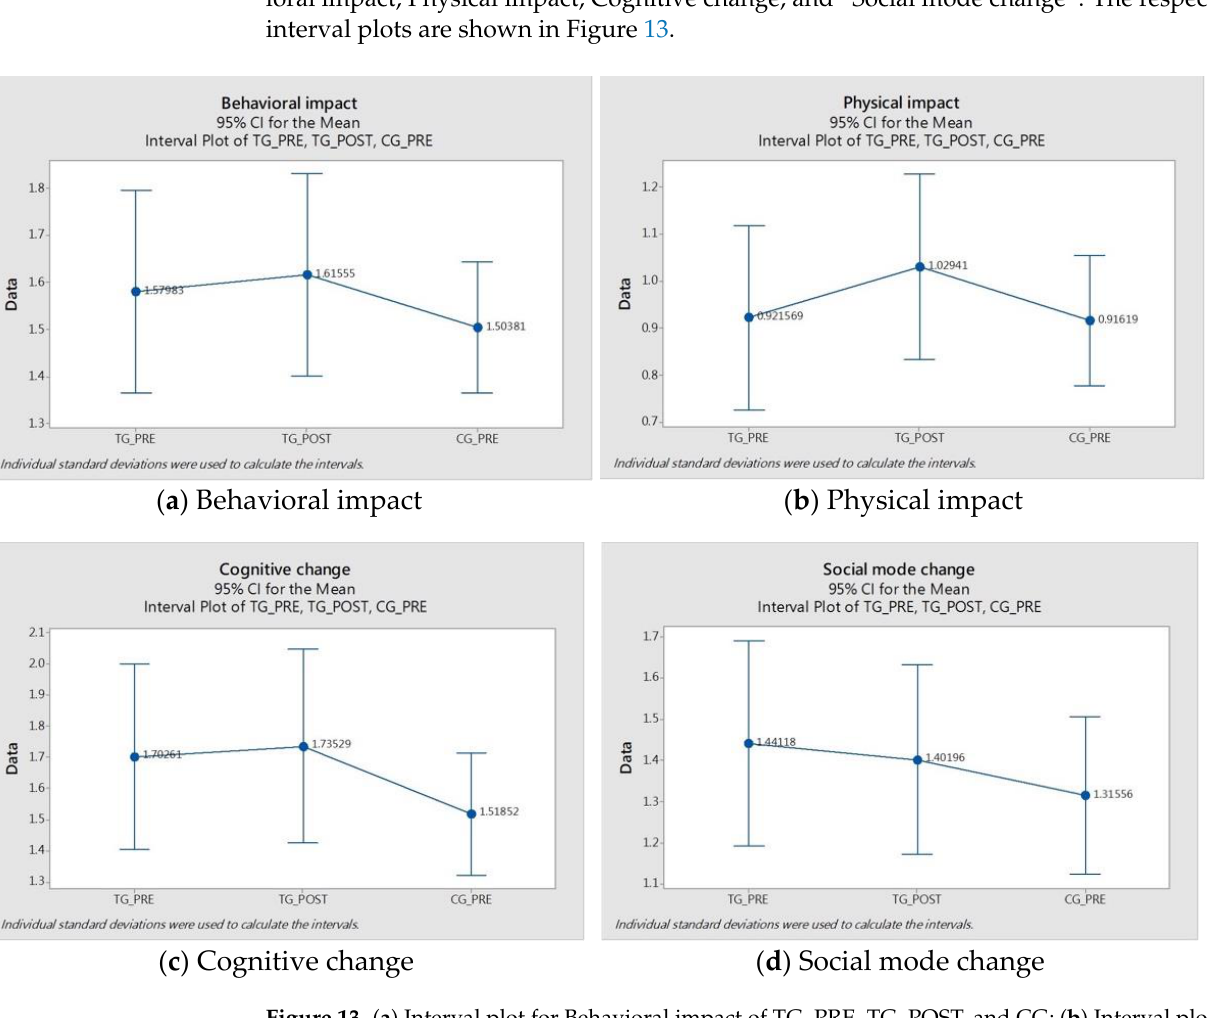
Figure 11. Interval plot for Psychological sensitivity of TG_PRE, TG_POST, and CG.